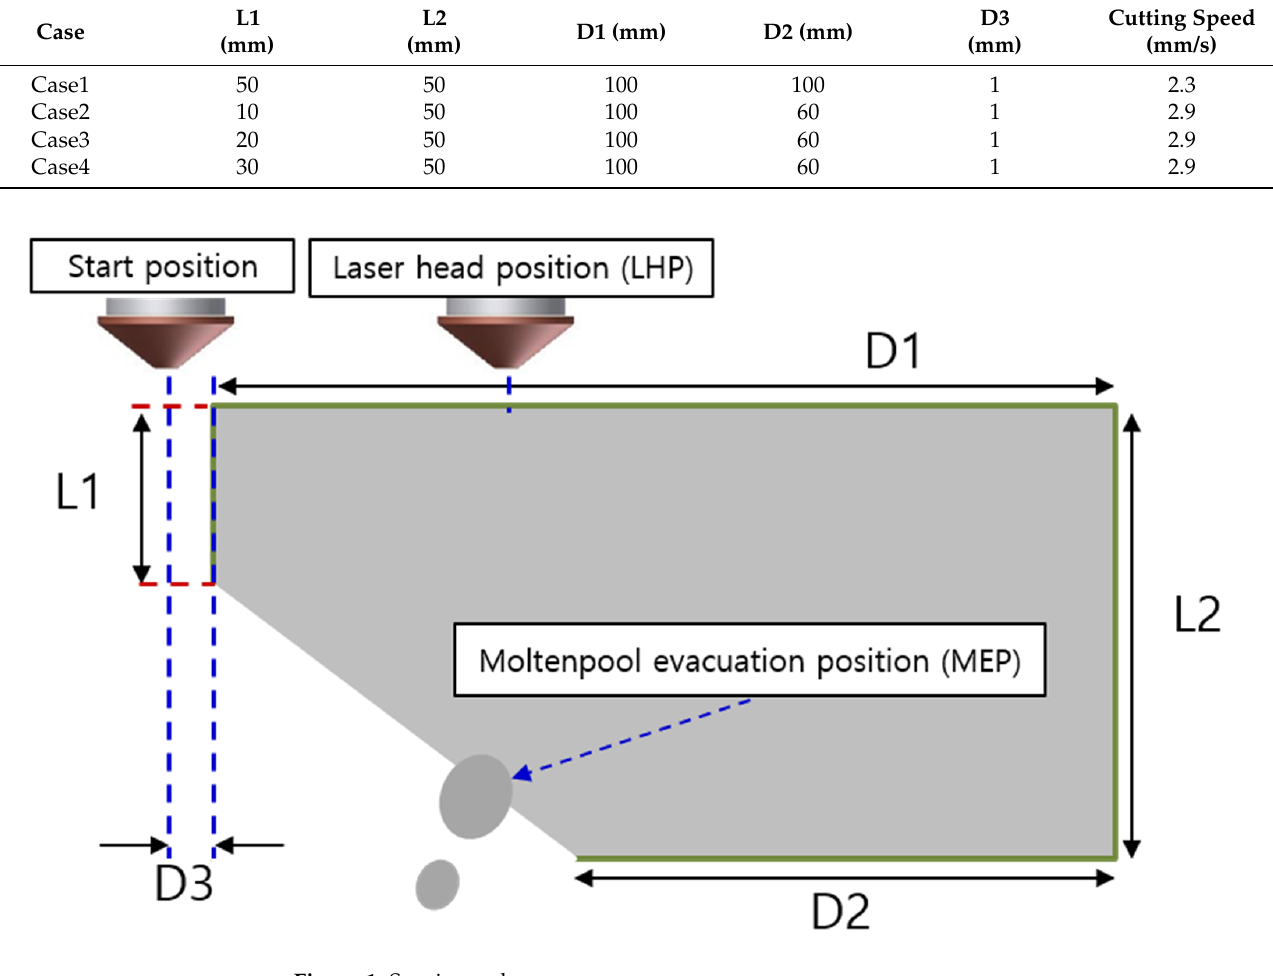
Figure 1. Specimen